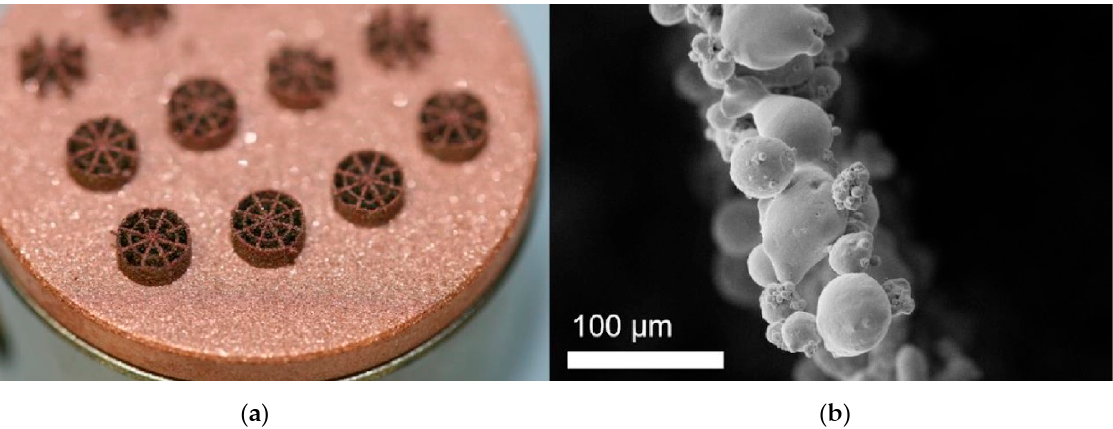
Figure 12. ( a ) Thin-walled circular samples; ( b ) SEM image of a single wall (Adapted from reference